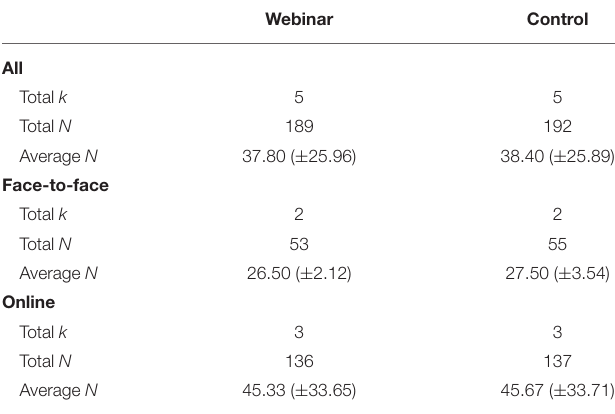
TABLE 3 | Number of data sources and participants per condition and subgroup.